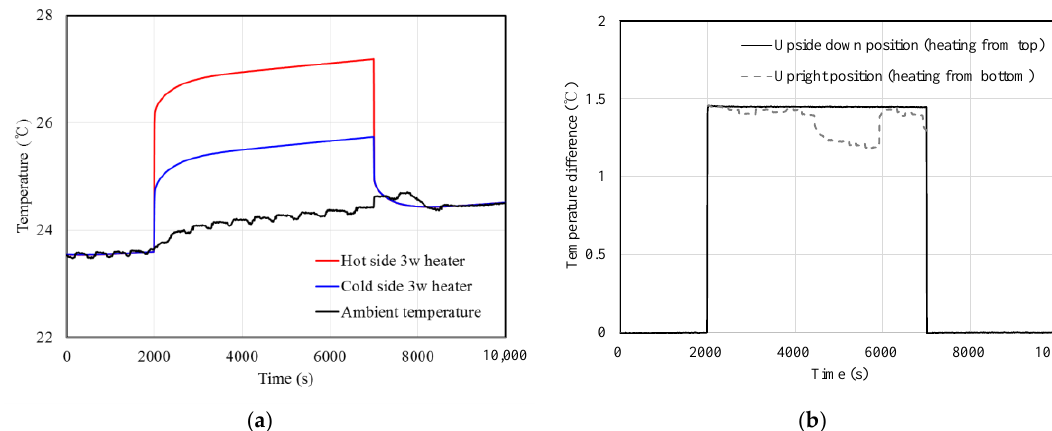
Figure 2. Transient measurement of ( a ) the temperatures of the hot and cold 3 ω heaters, as well as the ambient temperature, and ( b ) the temperature difference between the hot and cold 3 ω heaters in the presence of a droplet of ethylene glycol (EG) with a DC power input of 14 mW.